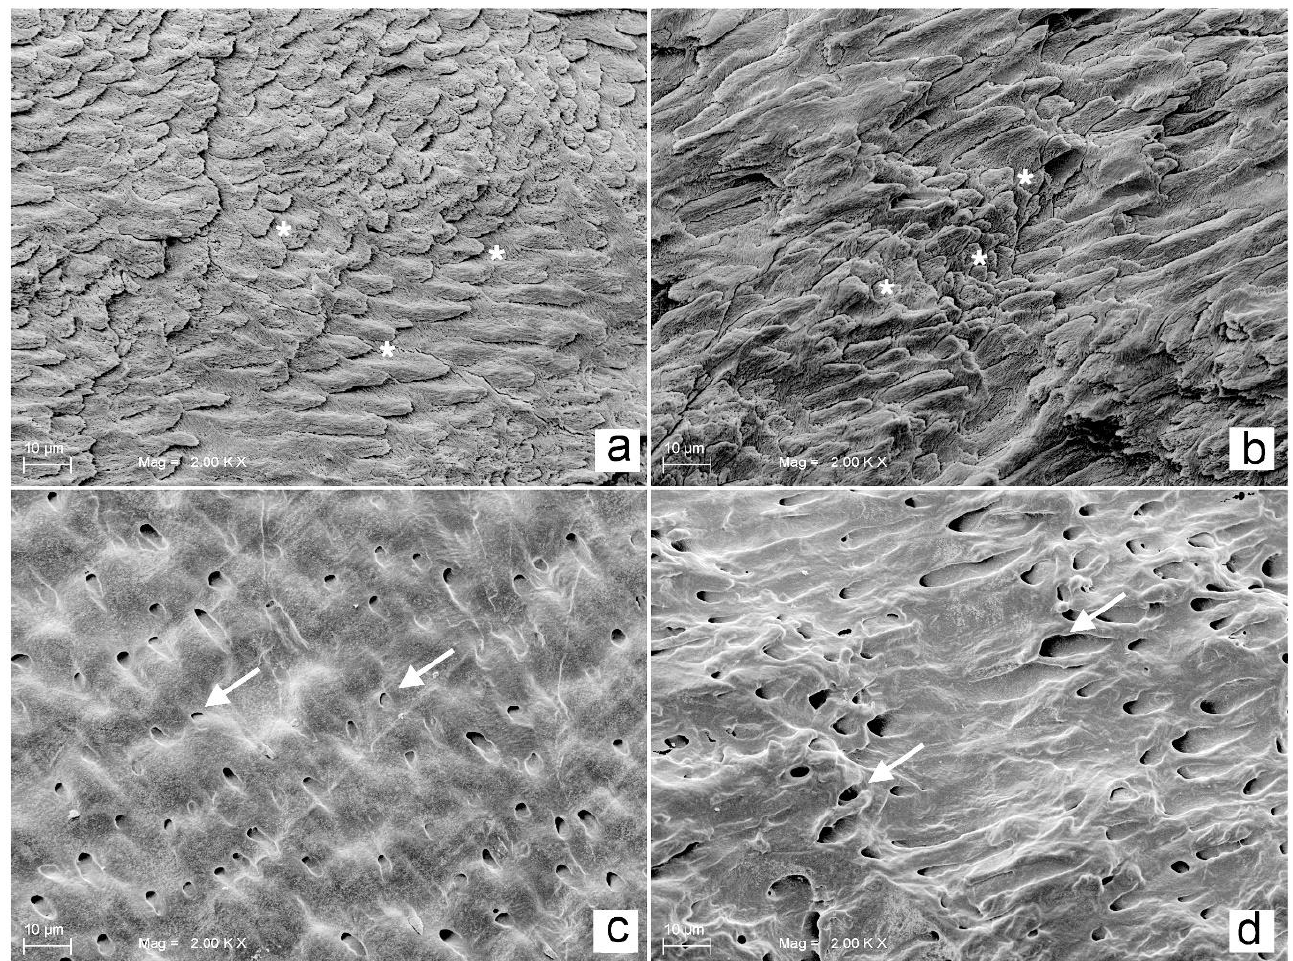
Figure 6. Comparison of enamel and dentin treated with acid-etching and WAPA and acid-etching procedures: ( a ) enamel acid-etched for 20 s, ( * ) rods of enamel prisms appear on the same level. Mag. 2000×; ( b ) enamel after WAPA and acid-etch treatment for 20 s, ( * ) rods of enamel prisms appear on different levels with a three-dimensional appearance. Mag. 2000 × ; ( c ) dentin after 20 s of etching, white arrows indicate open tubules which are located on the same level. Mag. 2000 × ; ( d ) dentin treated with WAPA followed by 20 s of etching, white arrows indicate open tubules which are located on different levels with a three-dimensional appearance. Mag. 2000 × . After comparing the SEM images ( a ) vs. ( b ) and ( c ) vs. ( d ) it was possible to note that the main difference between specimens that were acid etched and those that underwent acid etching and WAPA was related to the 3D architecture, which was much more present in the WAPA specimens, both for enamel and